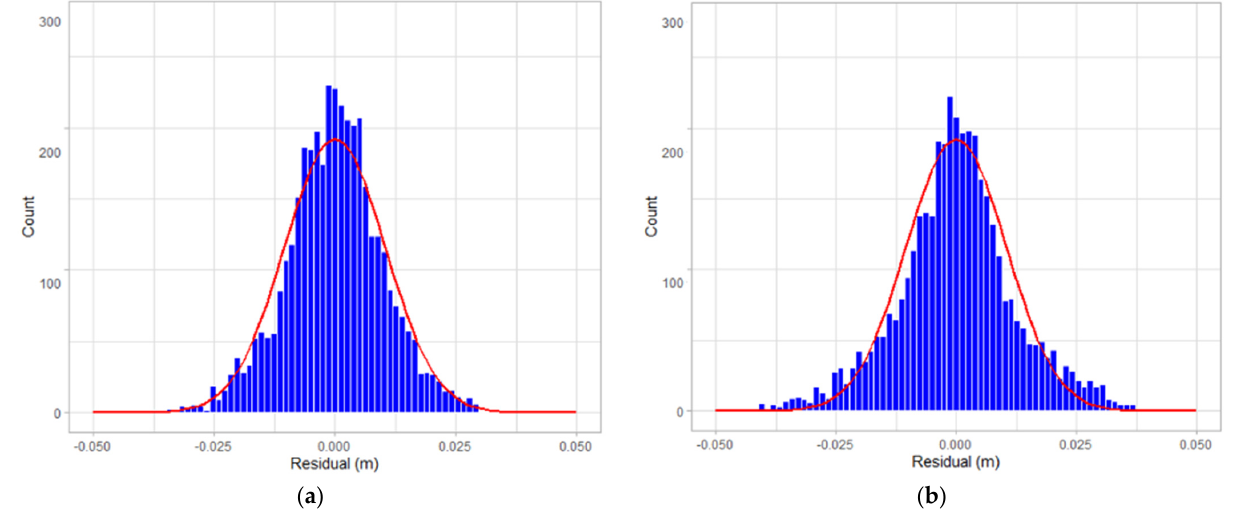
Figure 21. The residual distribution plots of dataset DATA3. ( a ) with Aps; ( b ) without Aps.